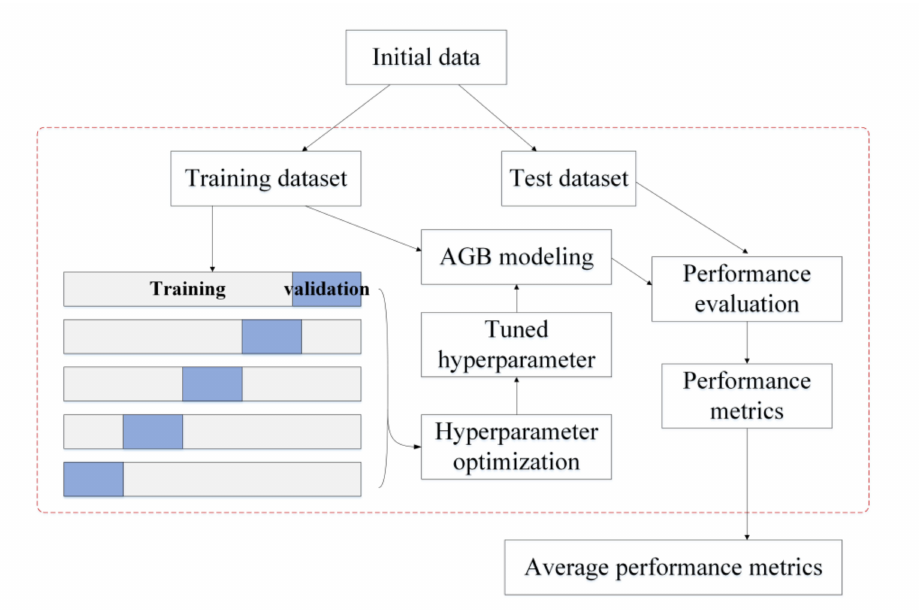
Figure 2. Experimental design for tuning hyperparameters and evaluating an AGB modeling